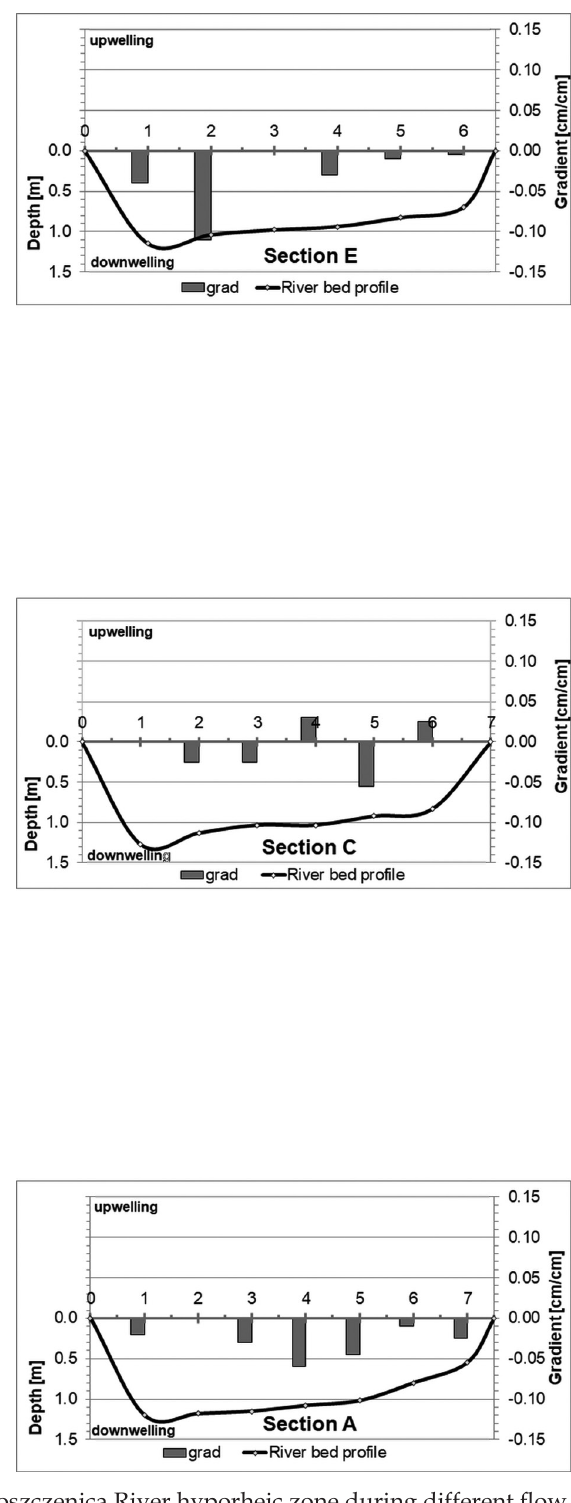
Fig. 8. Changeability of the hydraulic gradient in the Moszczenica river hyporheic zone during different flow